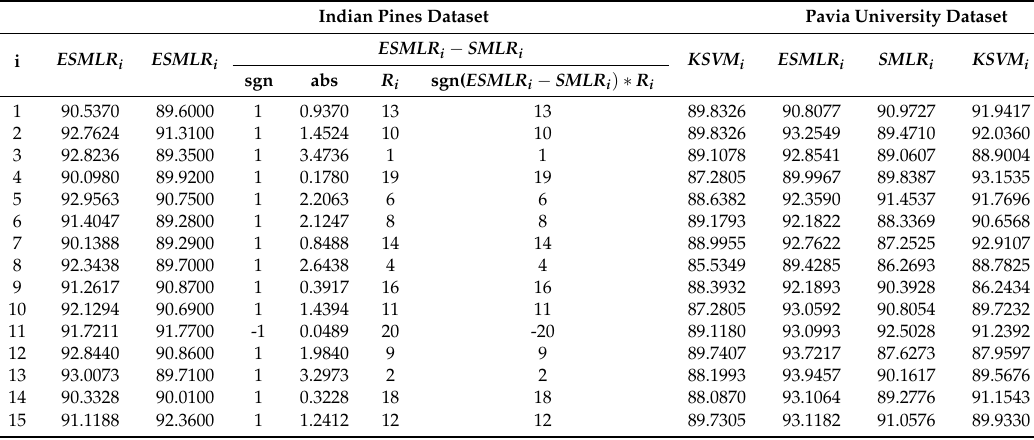
Table A3. Wilcoxon signed-rank